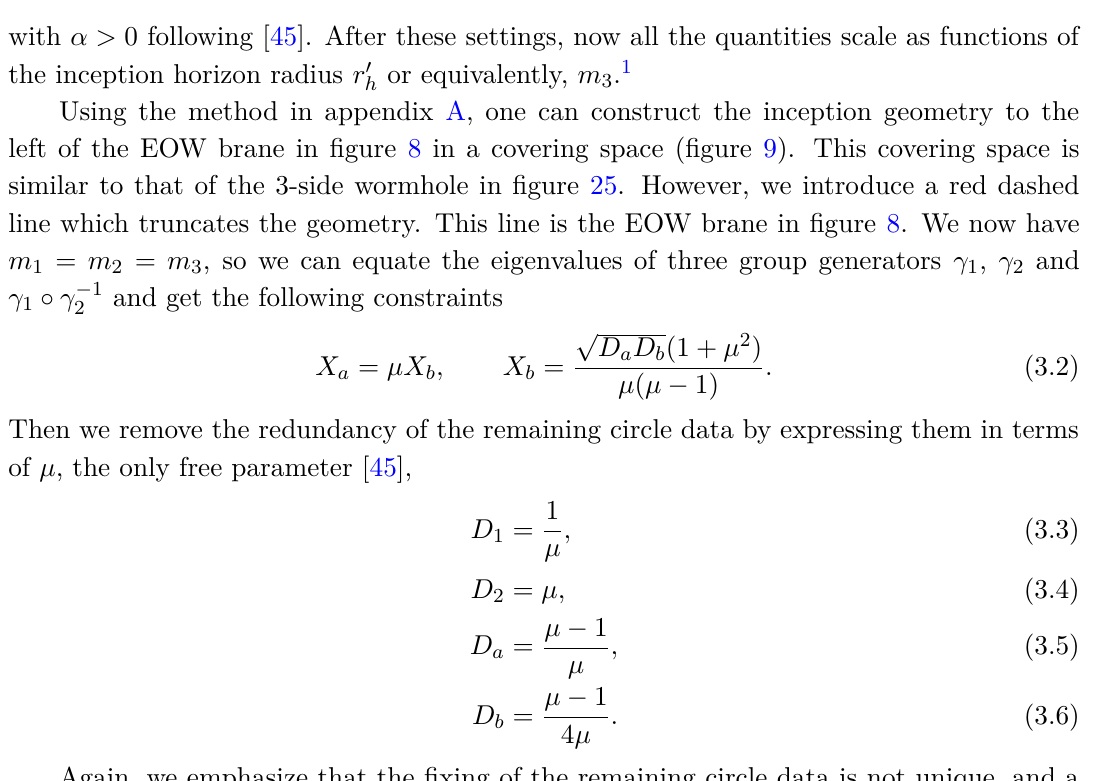
Figure 9 . A covering space depiction of the inception geometry (the blue shaded region). The red dashed line here is the EOW brane which must match the red dashed circle in figure 8. This covering space can be easily obtained by introducing an EOW brane that truncates the left side of figure